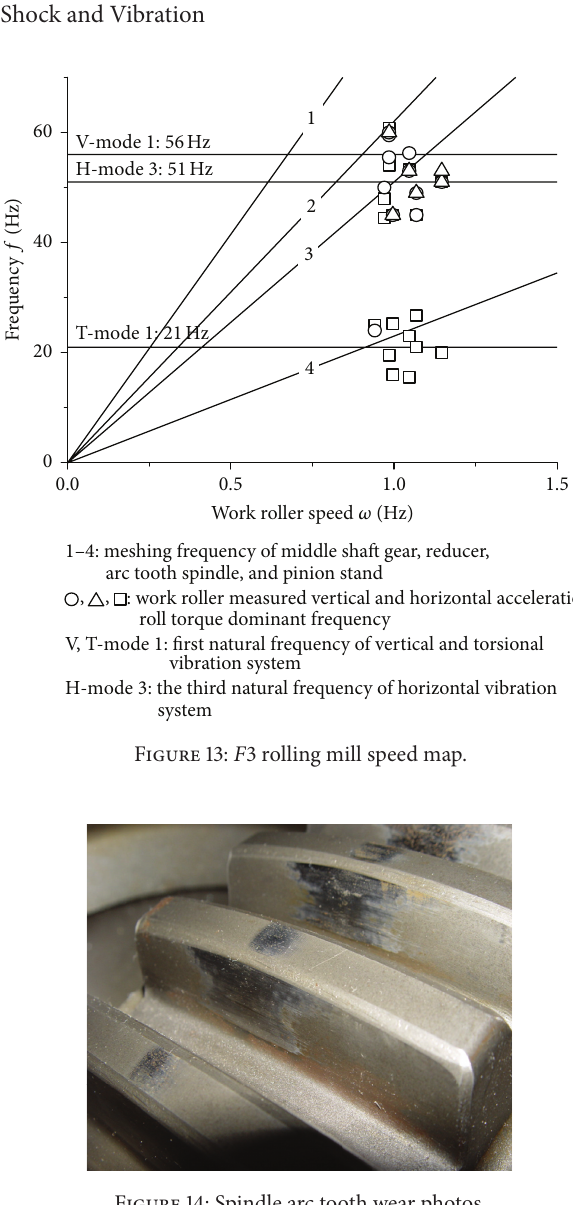
Figure 14: Spindle arc tooth wear